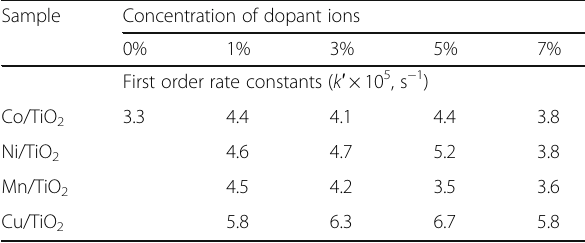
Table 2 First order rate constants ( k ′ × 10 5 , s − 1 ) Cr(VI) to Cr(III) ions photoreduction in the presence of TiO 2 and M n+ /TiO 2 (M – Co, Ni, Mn, Cu) films with different dopant concentrations Sample Concentration of dopant